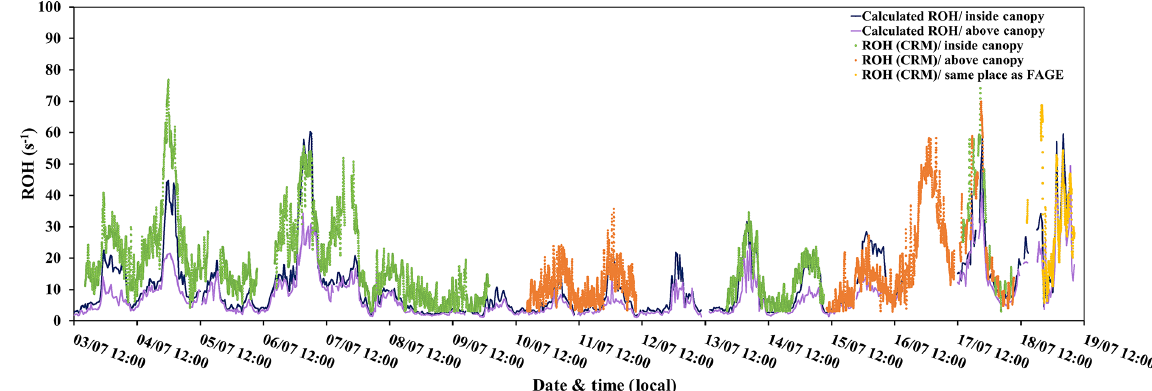
Figure 6. Variability of measured ROH (LSCE-CRM) and calculated ROH (PTR-MS) at 6 and 12m of